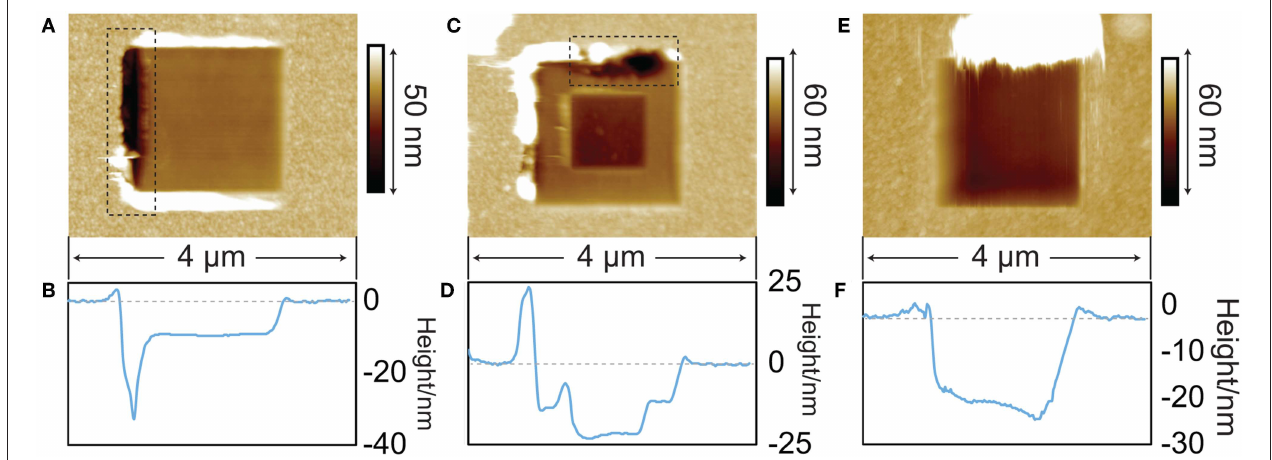
FIGURE 10 | Edging effect, highlighted by dashed boxes, on SiO x when etching with a diamond-coated probe. (A,B) Topography and cross section, respectively, showing the edging effect on a trench. (C,D) Topography and cross section, respectively, showing a trench in which the scan size has been reduced in order to alleviate the edging effect. (E,F) Topography and cross section, respectively, for a trench in which the deflection setpoint was gradually increased to the desired value, eliminating the edging